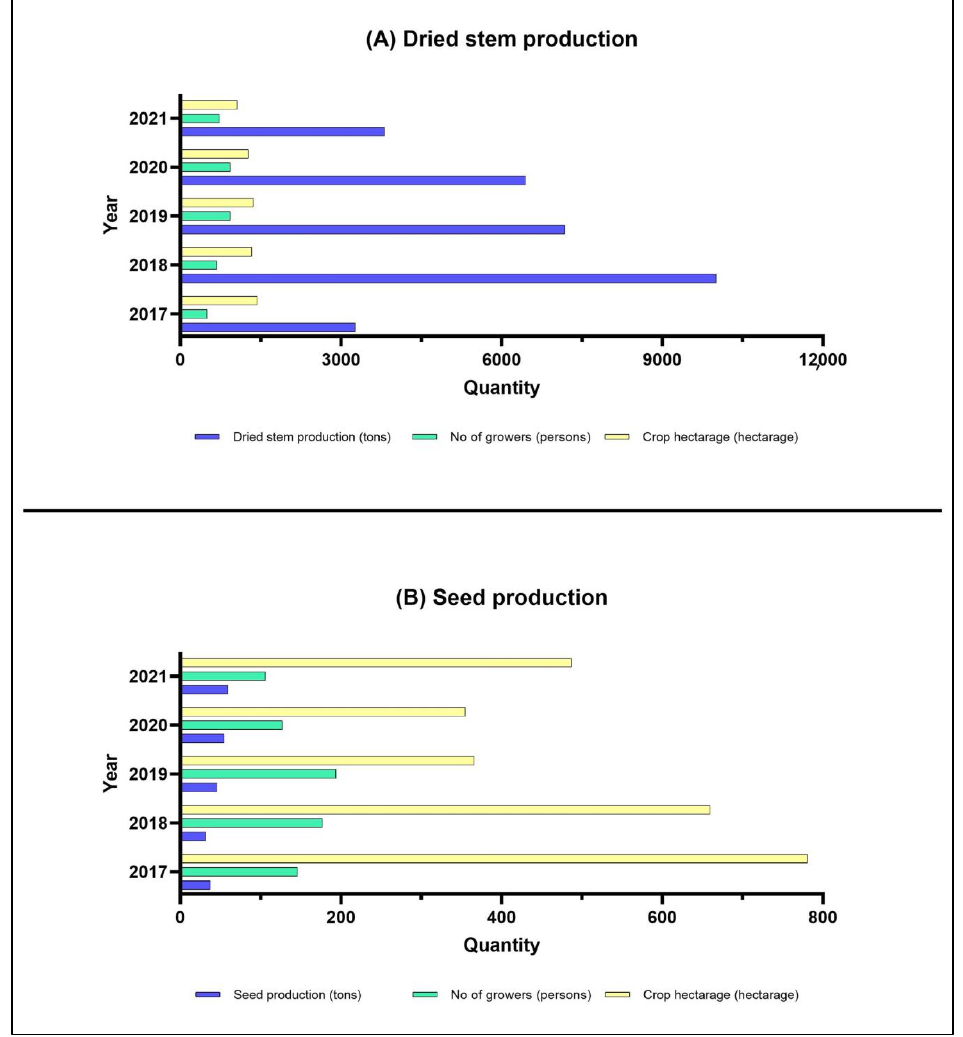
Figure 4. Kenaf plantation in Malaysia for;( A ) dried-stem production and ( B ) seed production. Data retrieved from LKTN [18] . Going forward, the National Kenaf and Tobacco Board (LKTN) set a target in increase kenaf plantation areas up to 10,000 hectares nationwide by the end of 2023 [27]. In fact, LKTN does provide various incentives to local farmers who intend to cultivate kenaf either for its fibre or seed production to realise the goal of making kenaf one of the nation’s main commodities. This exemplifies the immense support from the government to accelerate the adoption of the kenaf plant, especially within the industries. This trend also highlights the upcoming significance of kenaf in contributing to the economic sector of